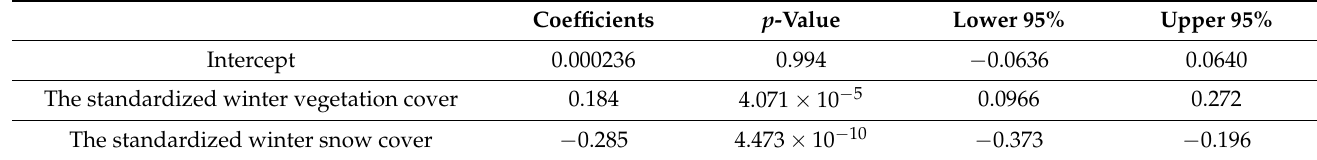
Table 11. T -test for each parameter